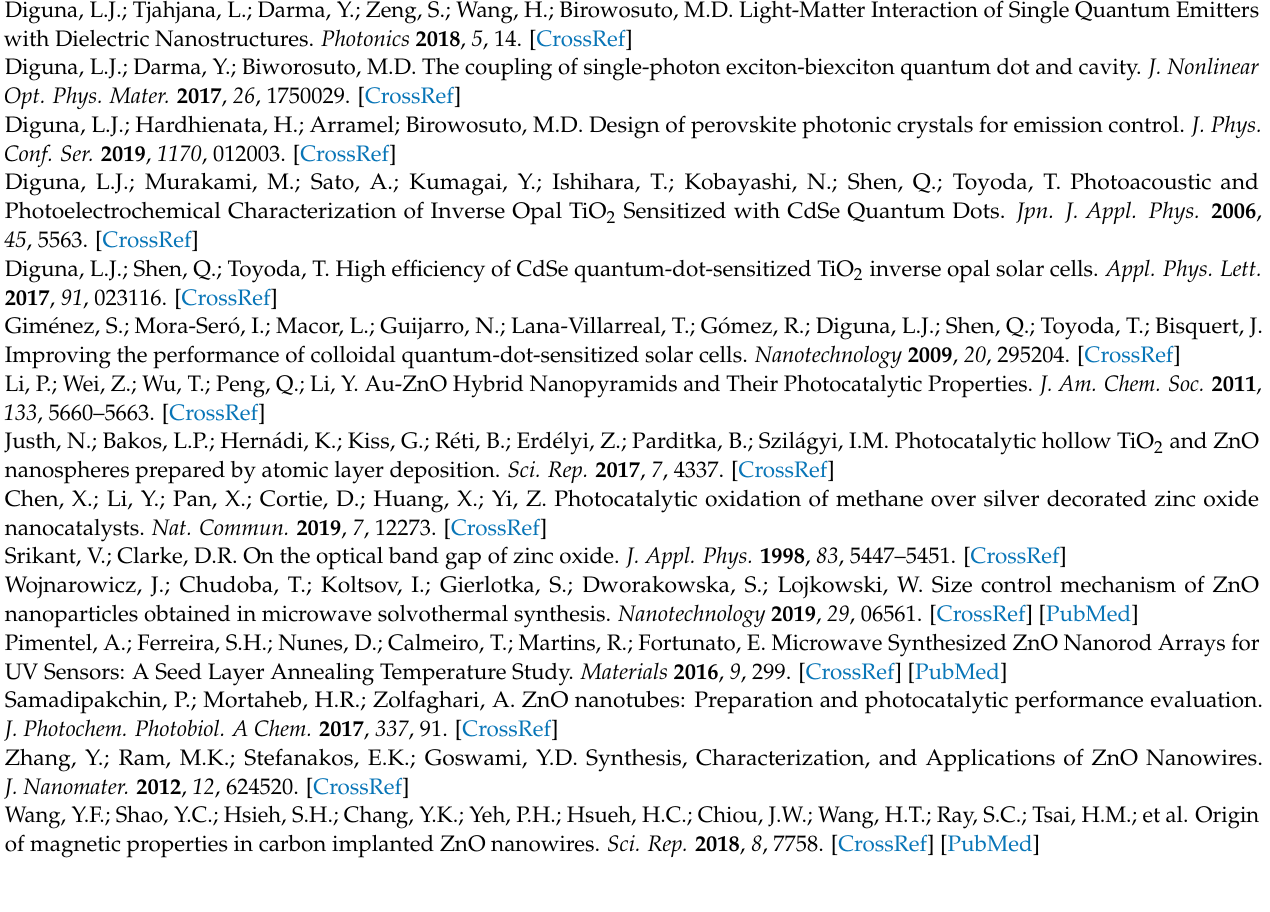
dross. Figure S2. SEM images of ZnO nanoparticle film. Figure S3. (a) Illustration of grain size with vertical and horizontal measurements. Zn dross-originated ZnO grain size distribution histograms of (b) horizontal and (c) vertical diameters determined from the SEM image. Figure S4. Tauc plot for Zn dross-originated ZnO nanoparticles as a function of photon energy, revealing the band gap energy of 3 eV (413